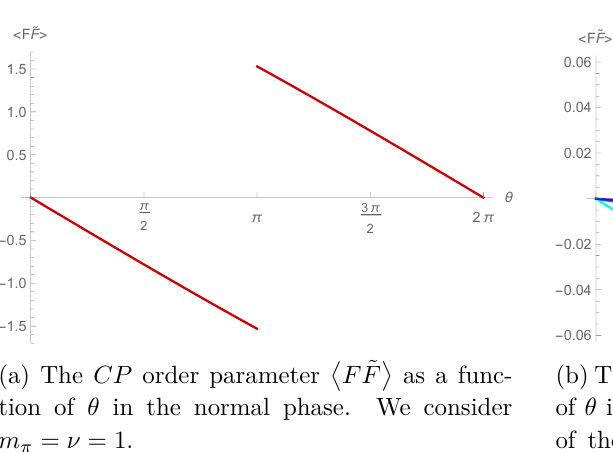
(b) The CP order parameter (cid:10) F ˜ F (cid:11) as a function of θ in the superfluid phase for different values of the chemical potential: µ = 5 , 10 , 15 . We consider m = ν = 1 . π